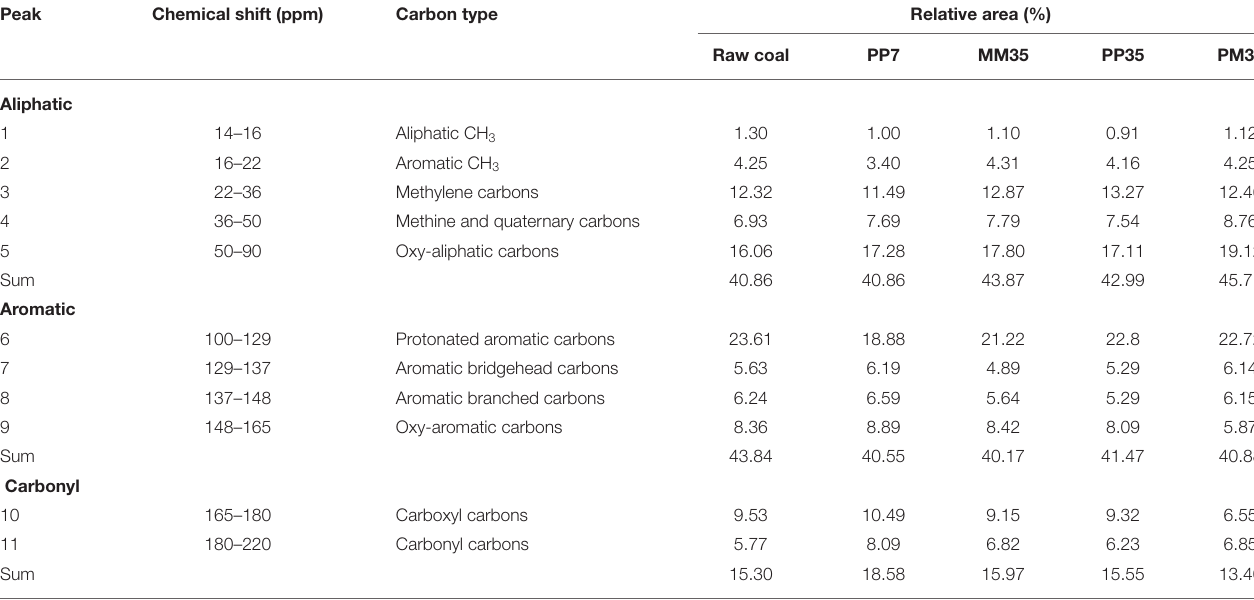
TABLE 1 | Assignments and percentages of different functional groups in coal based on 13 C-NMR spectra.